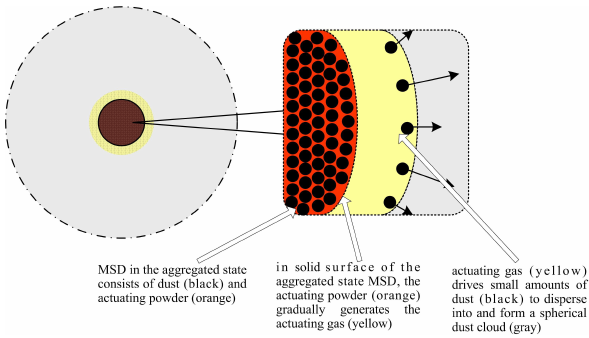
Figure 7. Spread of micrometer-scale dust from the aggregated